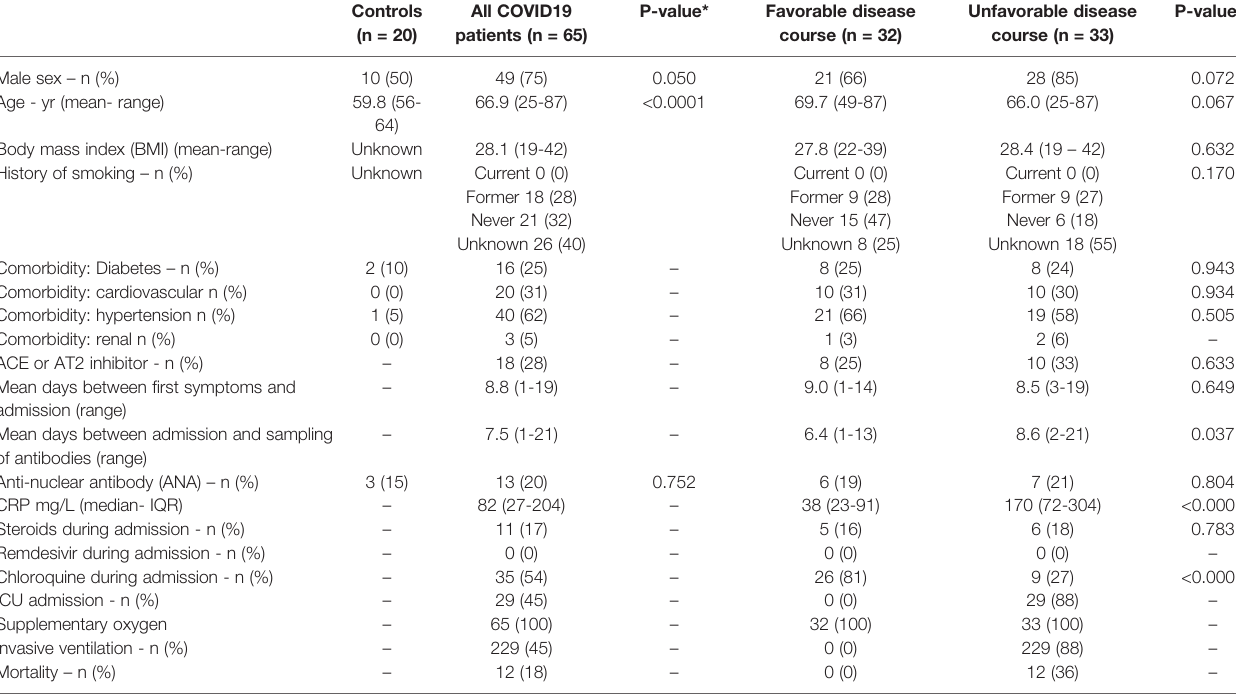
TABLE 1A | Demographics and Clinical Features of COVID19 Patients Classi fi ed as “ favorable ” and “ unfavorable ” disease course.